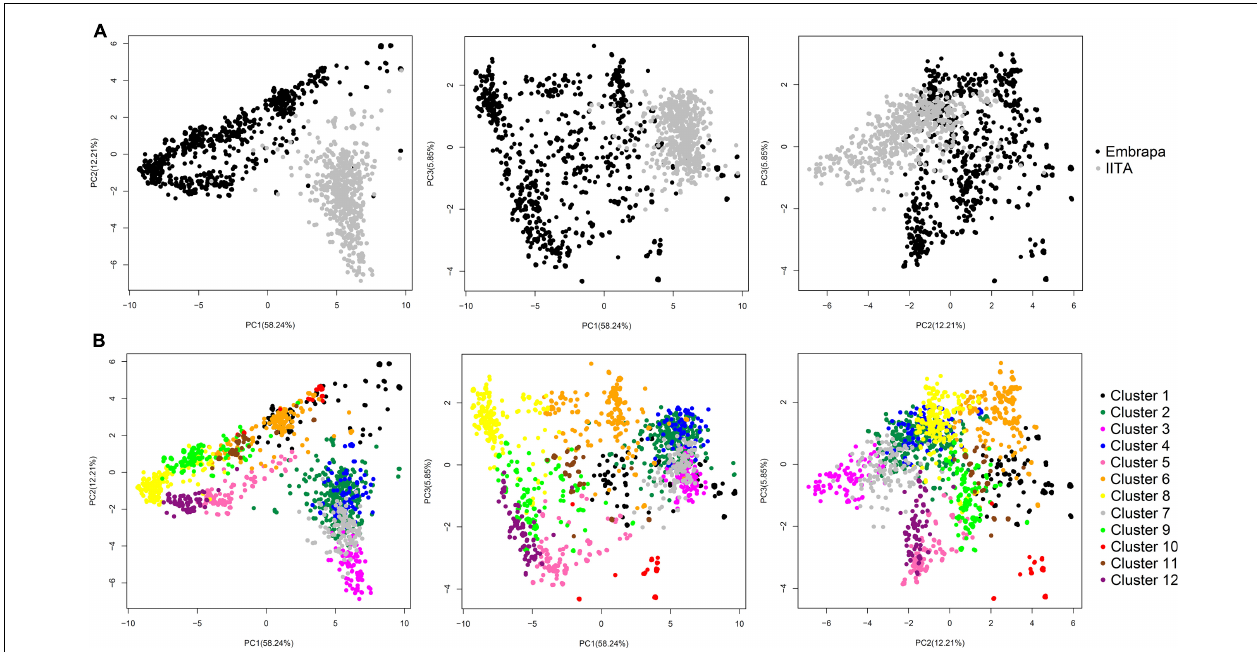
FIGURE 1 | Principal components analysis (PCA) of the genomic kinship coefficients between cassava clones. (A) PCA from the genomic relationship matrix between all cassava clones ( N = 1,820; 14,924 SNPs) from Brazil (Embrapa) and Nigeria (IITA), showing the first three principal components and the variance explained by each component in parenthesis on the corresponding axis (58.24, 12.21, and 5.85% for PC1, PC2, and PC3, respectively). In black representing Embrapa clone’s dispersion and in grey representing IITA’s. (B) PC diagram highlighting the 12 clusters identified by the DAPC analysis.